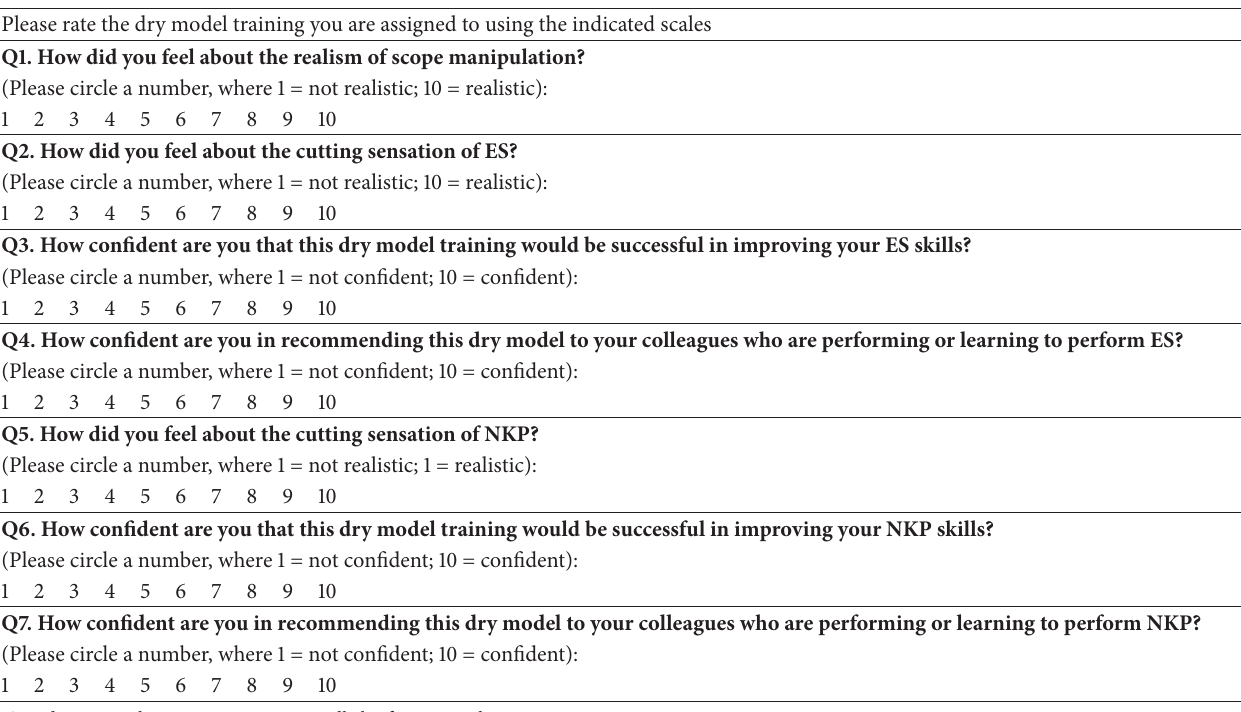
Figure 2: Creation of the simulated papilla. (a) A piece of rolled uncured ham was inserted into the opening with the tip protruding. (b) For the transmission of current, the model was earthed via a conventional cable connected to the simulated papilla. Table 1: Questionnaire regarding the dry